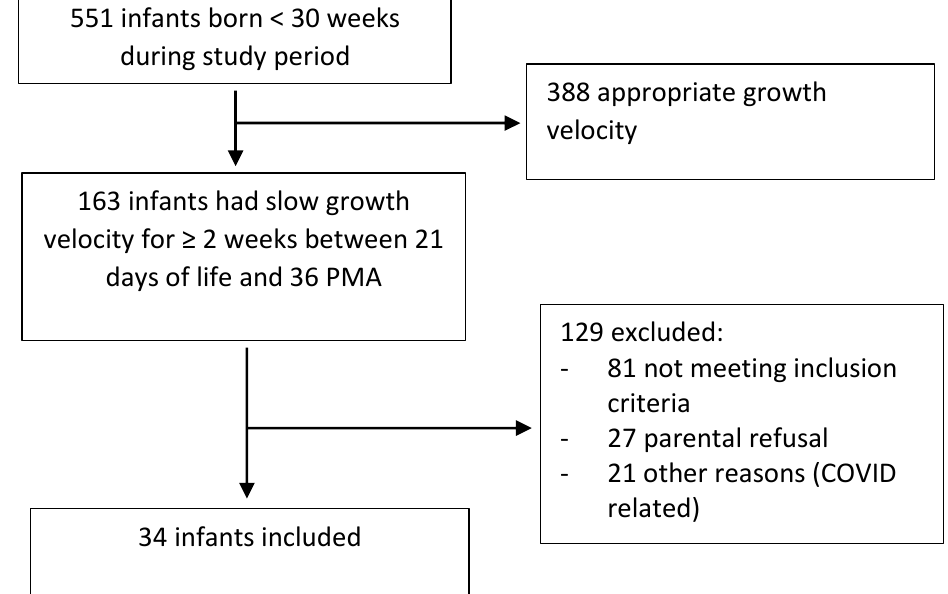
Figure 1. Study flow diagram.